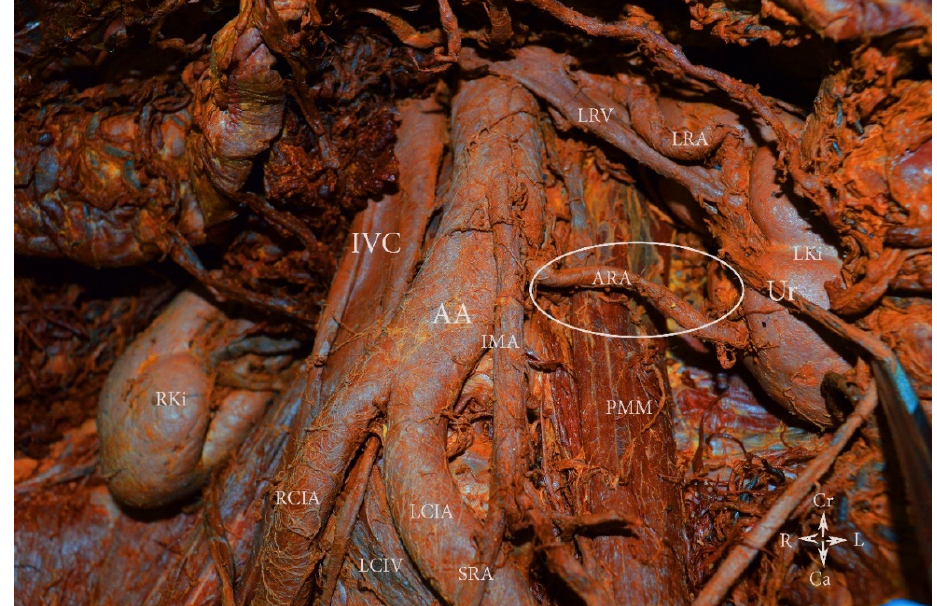
Figure 9. Additional right aortic upper polar renal artery and accessory right aortic lower polar ar- tery arising from the abdominal aorta and the right common iliac artery, respectively. The arteries have a precaval course (open surgery performed by doctor Ilker Selcuk). IVC—inferior vena cava, A—abdominal aorta, U—right ureter, RCIA—right common iliac artery.